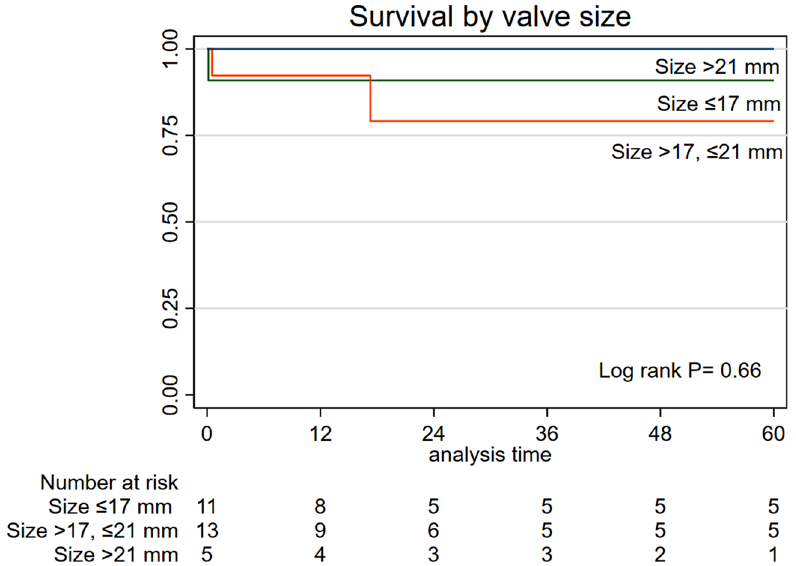
Figure 5. Kaplan–Meier survival curves according to valve